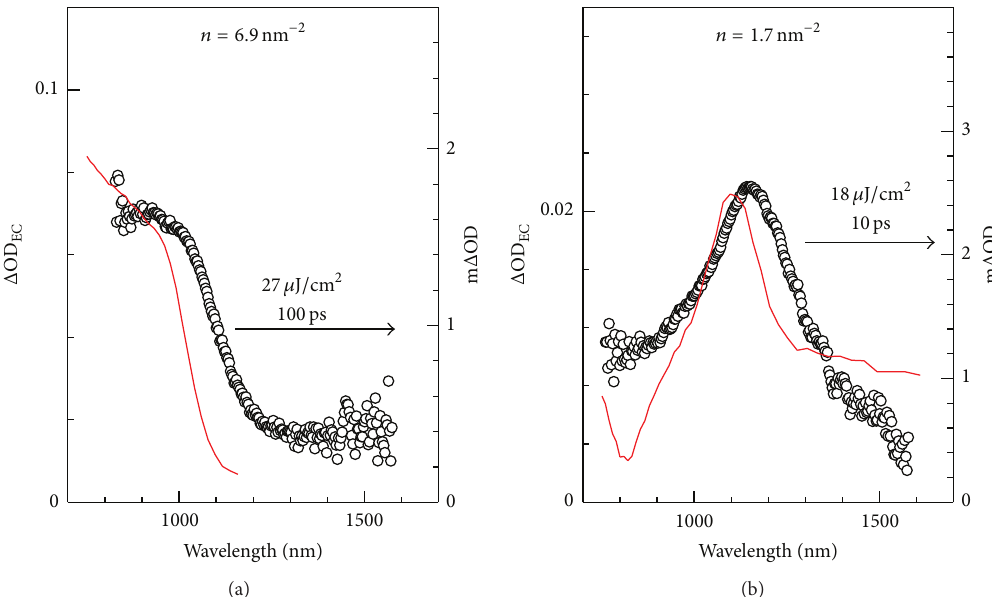
Figure 7: Electrochemical differential ( Δ OD EC ) spectra of neat (a) rr-P3HT and (b) PTB7 films. Open circles represent Δ OD spectra of (a) rr-P3HT/PCBM and (b) PTB7/PC 71 BM blend films. The data were replotted from